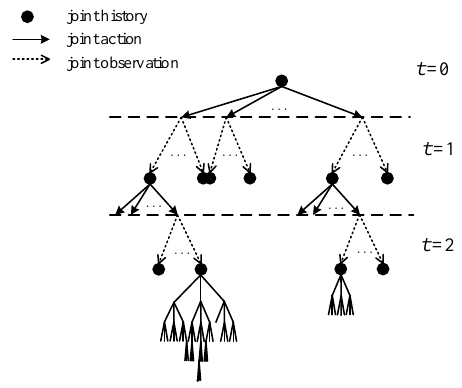
Figure 1. Tree of Monte Carlo Q-value function.